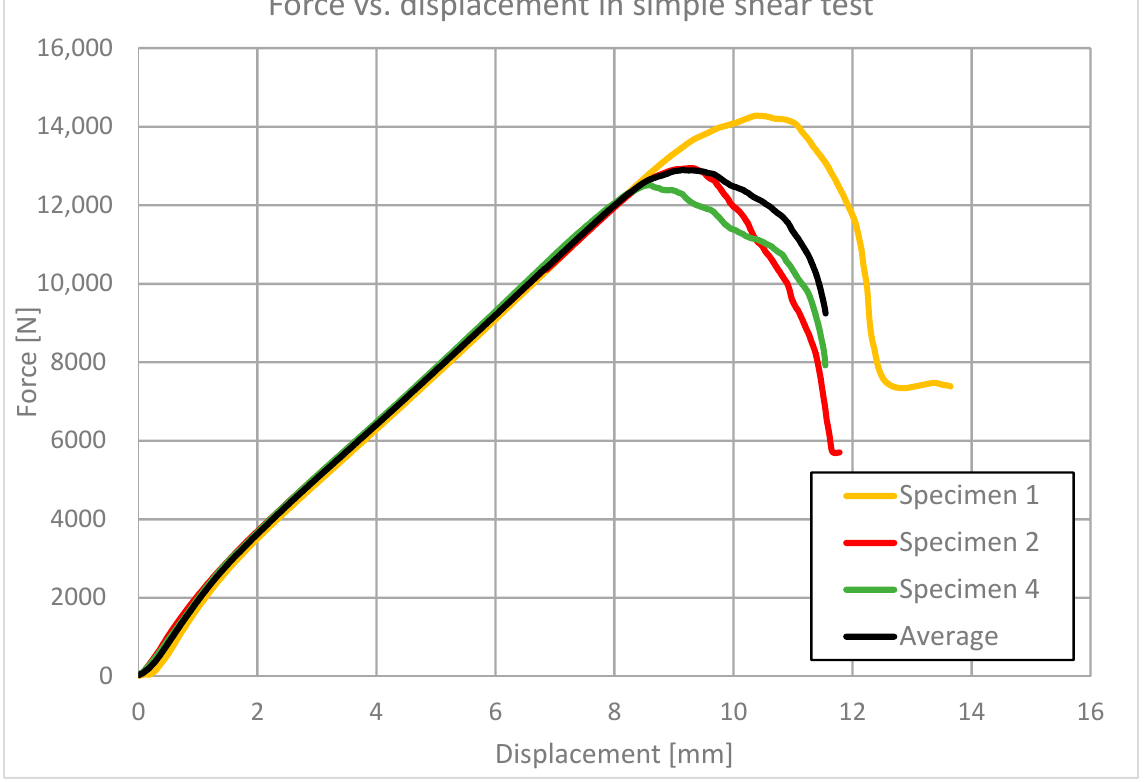
Figure 6. The force–displacement curve for four 100 × 100 × 10 three-concrete block specimens in simple shear tests, and an average curve.